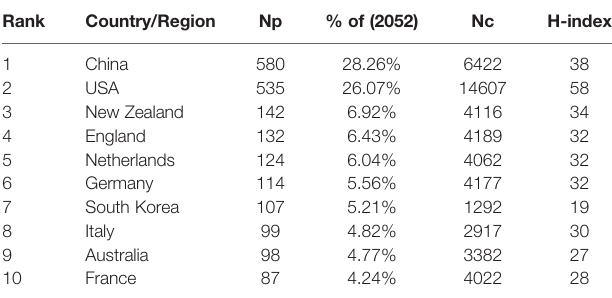
TABLE 2 | The top ten countries/regions with the highest